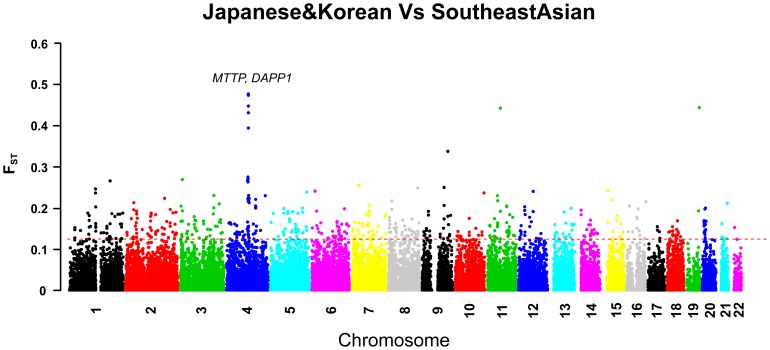
Signatures of MTTP and DAPP1 in the comparison of Southeast Asian populations with Japanese and Koreans.SNP-specific FST statistic between Japanese&Korean populations and Southeast Asian populations was calculated for each genotyped SNP. MTTP and DAPP1 on chromosome 4 showed significantly high FST values. The horizontal line indicates a 1% genome-wide cutoff level.